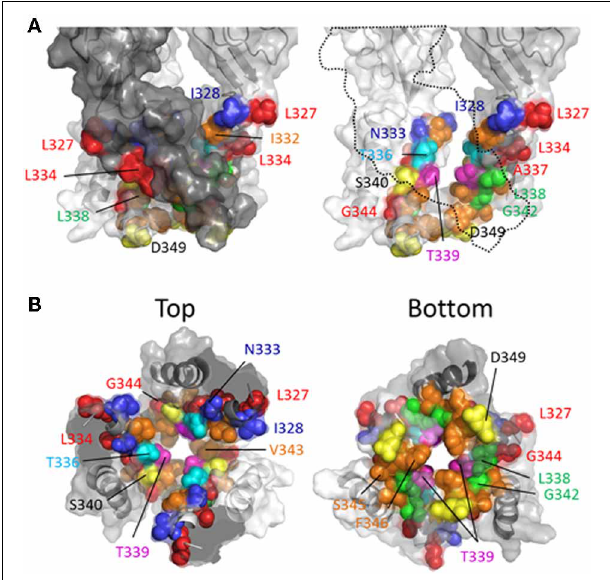
FIGURE 4 | Mapping P2X2R TM2 side-chains accessible to water-soluble thiol-reactive agents in the open state using SCAM. Side chains at which cysteine substitution renders the mutant receptor sensitive to current modification by thiol-reactive agents applied in the open channel state are shown as ball models. (A) Side view of TM domains shown with all subunits present (left panel) or the third subunit omitted for clarity (right panel). (B) TM domains viewed from extracellular (left panel) and intracellular perspectives (right panel). Color coordination is as follows: Red, mutant currents modified by Ag + only; Yellow, mutant currents modified by MTSEA + only; Orange, mutant currents modified by MTSET + and Ag + ; Green, mutant currents modified by MTSEA + and Ag + ; Blue, mutant currents modified by Ag + , MTSEA + , MTSET + , and MTSES − ; Cyan, mutant current modified by Ag + , MTSET + , MTSES − , MTS-TPAE + , and Texas Red-MTSEA + ; Magenta, Ag + , MTSEA + , MTSET + , MTS-TPAE, but not Texas Red-MTSEA + or MTSES −